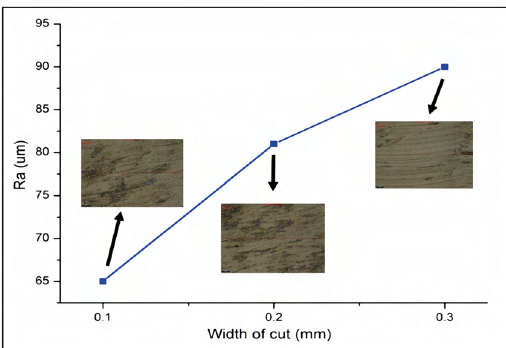
Figure 8. Surface roughness for different